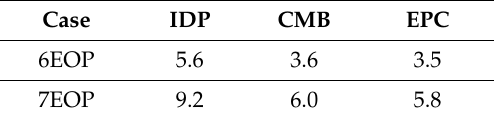
Table 9. Mean tie point precision (3D). All results are shown in